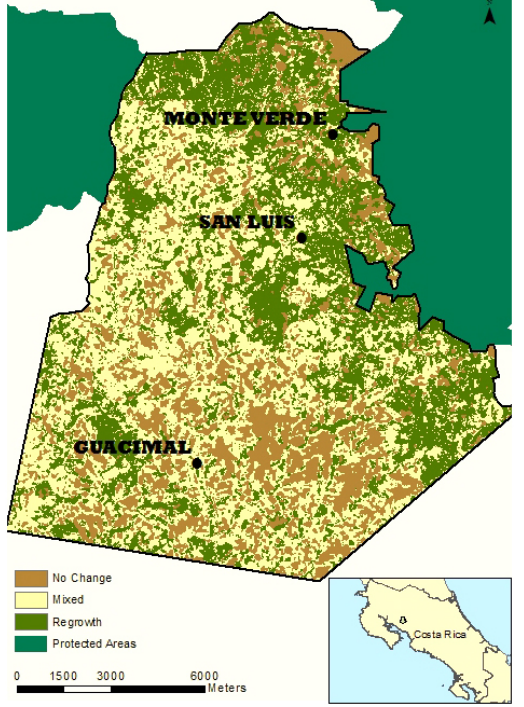
Fig. 1 . Map of the study area depicting forest regrowth between 1985 and 2009. Classes indicate no change, regrowth, and mixed. Location of study area within Costa Rica is